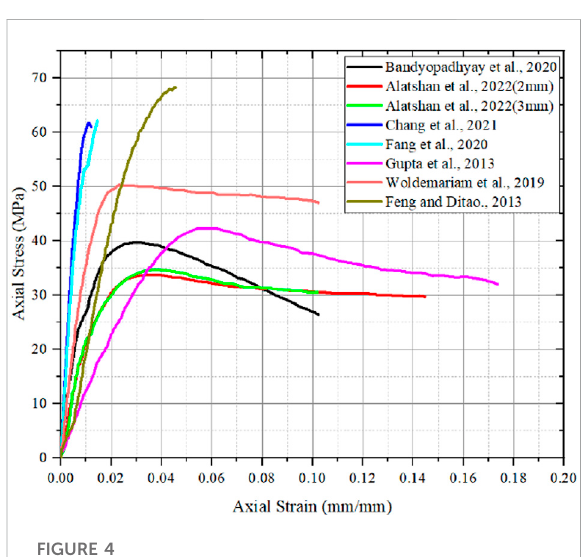
FIGURE 4 Stress strain of PVC material used in this